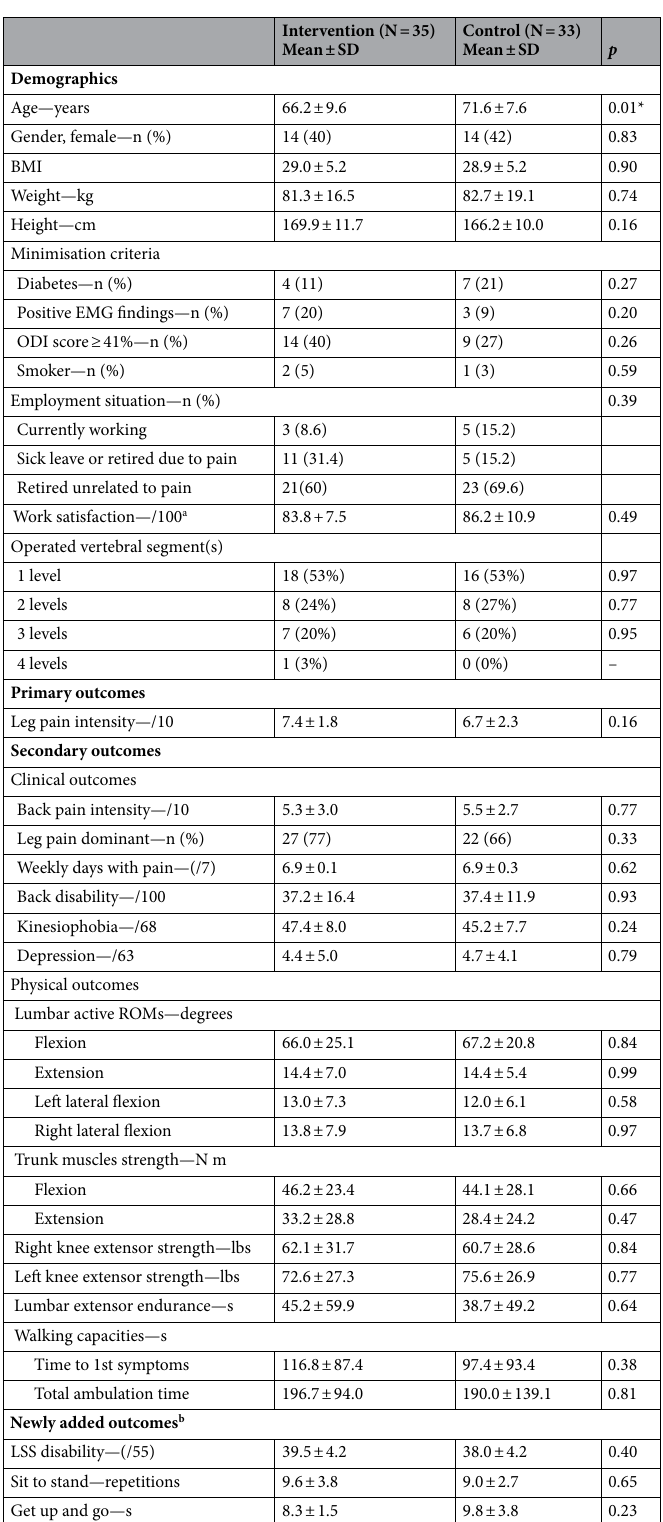
Table 1. Participants’ baseline characteristics. EMG electromyography, ODI Oswestry disability index, LSS lumbar spinal stenosis. *Statistically significant difference between groups. a Measured using the Minnesota Satisfaction Questionnaire 37 , results based on 4 participants from the intervention group and 5 from the control group (those employed or on sick leave at the time of the study). b For the newly added outcomes, 15 and 13 participants provided data from the intervention and control group